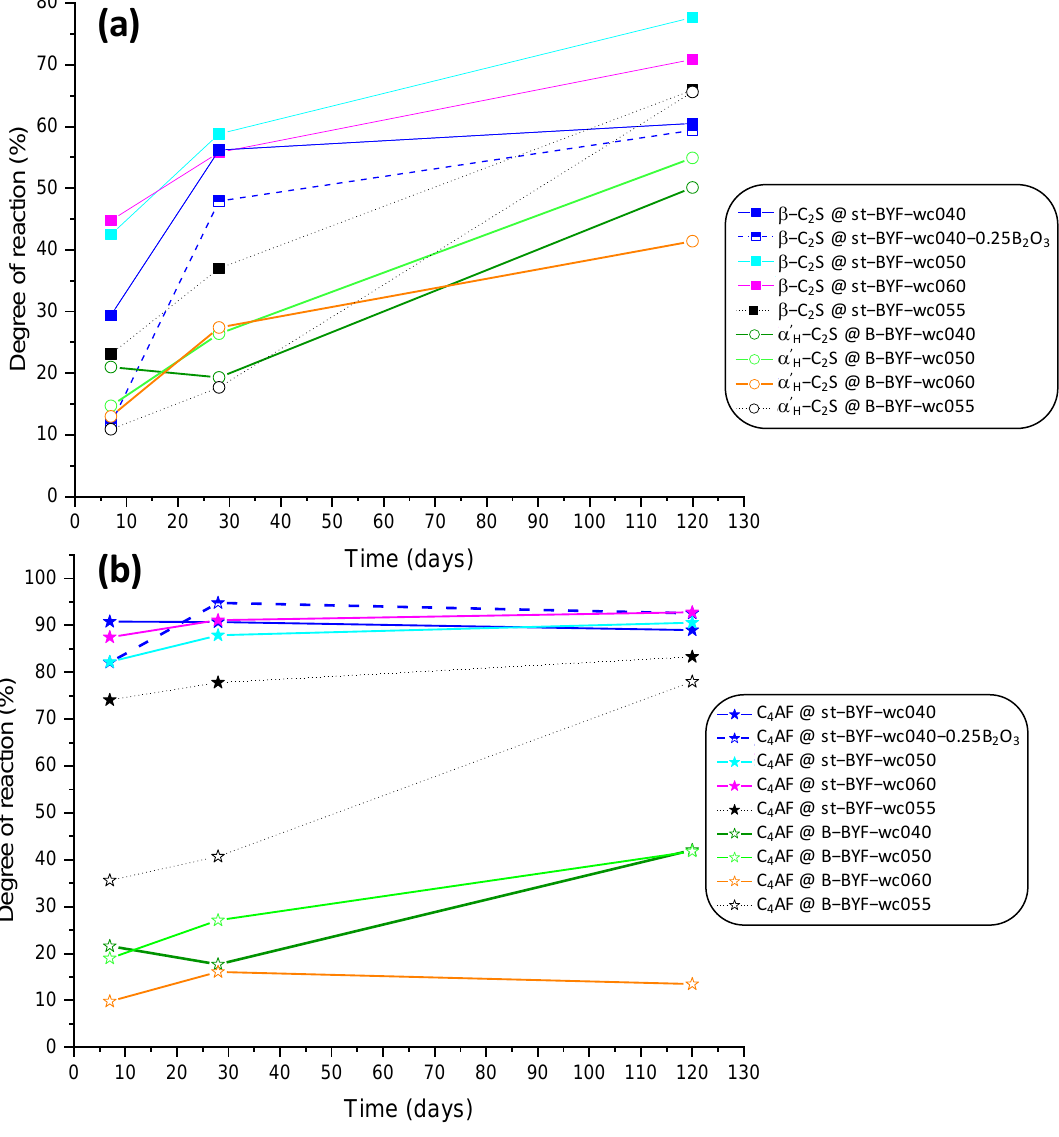
Figure 6. Degree of reaction of ( a ) β -C 2 S and α ’ H -C 2 S and ( b ) C 4 AF in all BYF pastes. Data calculated from [22] for w/c of 0.55 are also included.